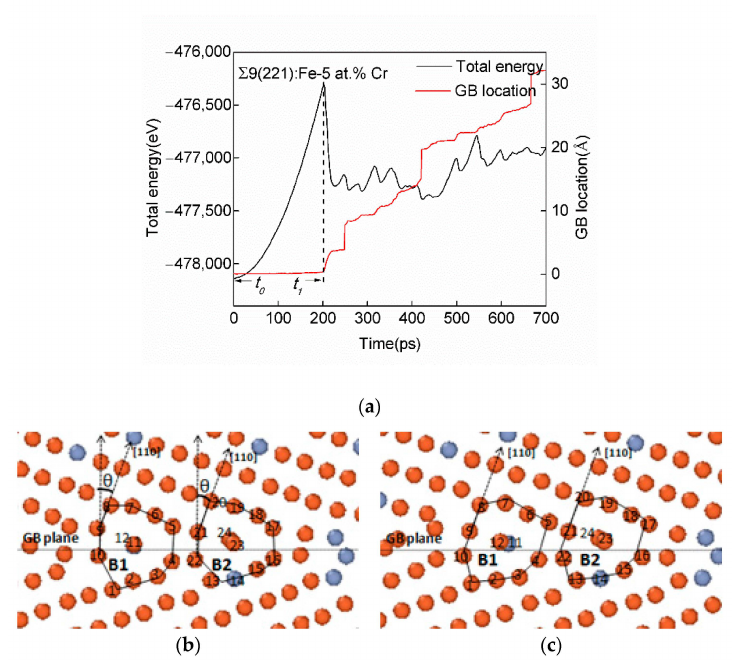
Figure 8. ( a ) System energy-time and GB location-time plots, and ( b ) the initial and ( c ) transition states of the Σ 9(221) GB in the Fe-5 at.% Cr alloy. Red circles represent Fe atoms and light gray circles represent Cr